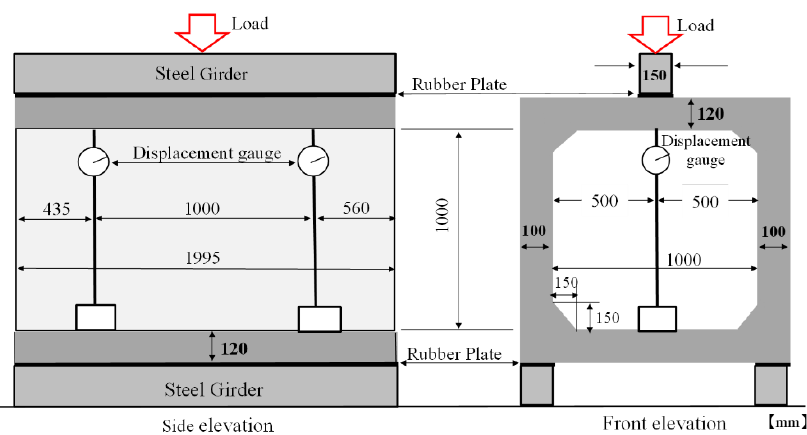
Figure 16. Loading test for mock-up specimen of the box culvert.